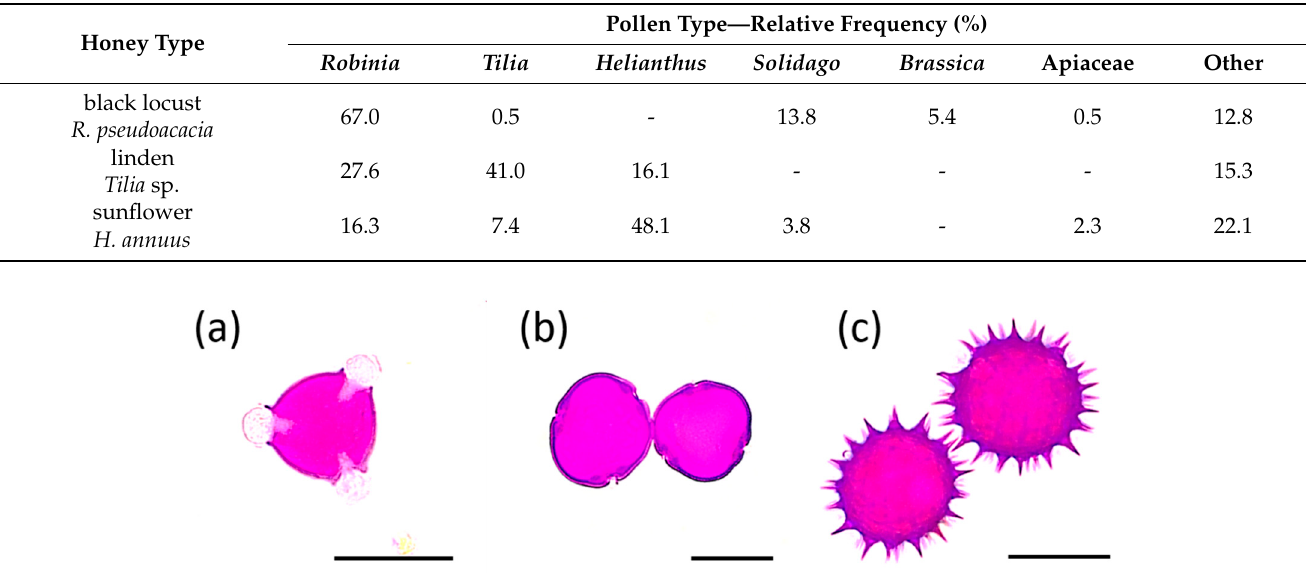
Table 1. Relative frequency of pollen types in Hungarian black locust, linden, and sunflower honeys.